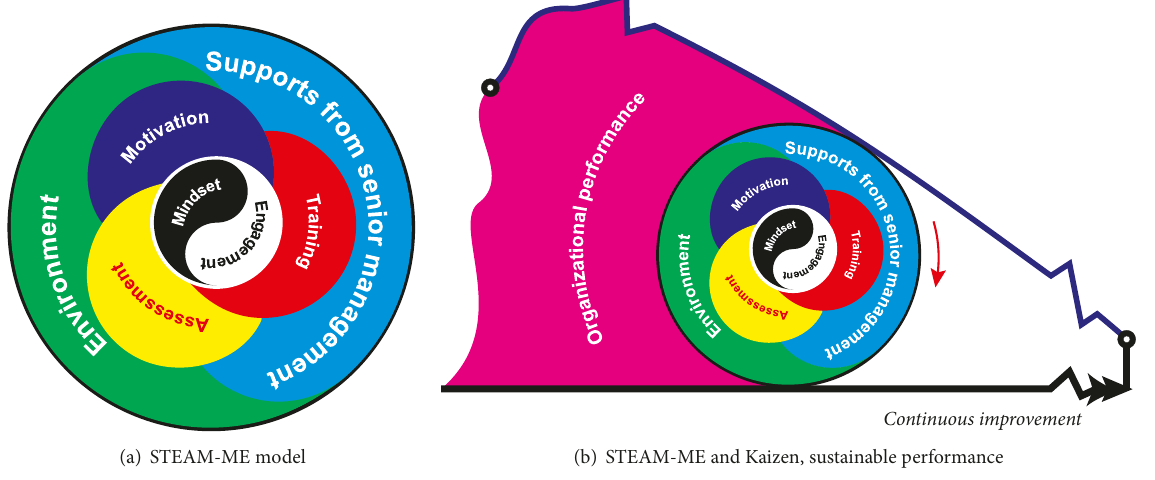
Figure 5: STEAM-ME